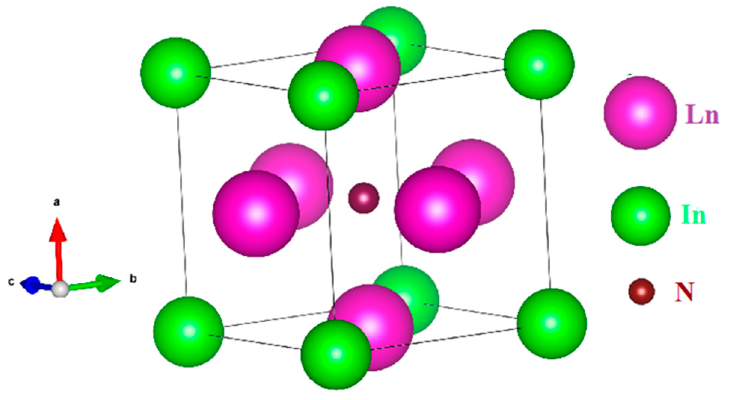
Figure 2. Unite cell structure of the rare earth nitrides Ln 3 NIn (Ln = Dy-Lu) anti-Perovskite.